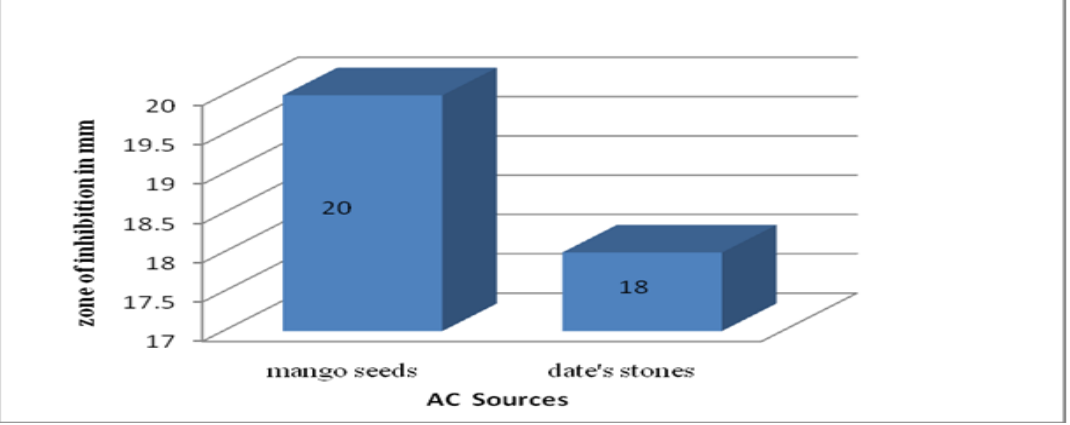
Figure 1. Showing that antibacterial activity of AC from Mango seeds and Date's stones against E. coli .